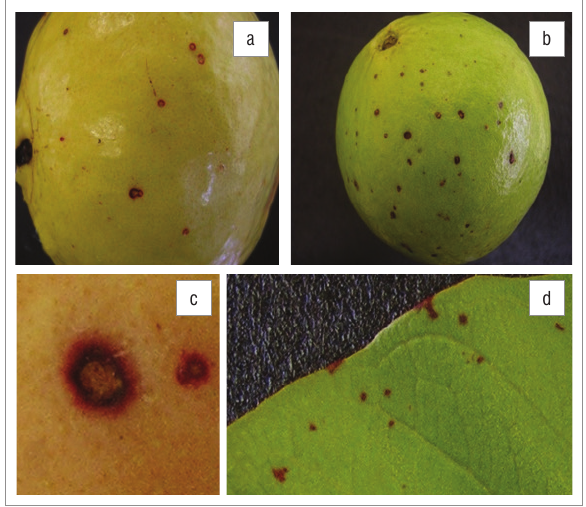
Figure 1: Symptoms of pink spot on fruit and leaves: (a) initial slight depression with brick red margin, (b) green fruit showing dark reddish brown lesion, (c) a mature spot and (d) pink spot symptoms on